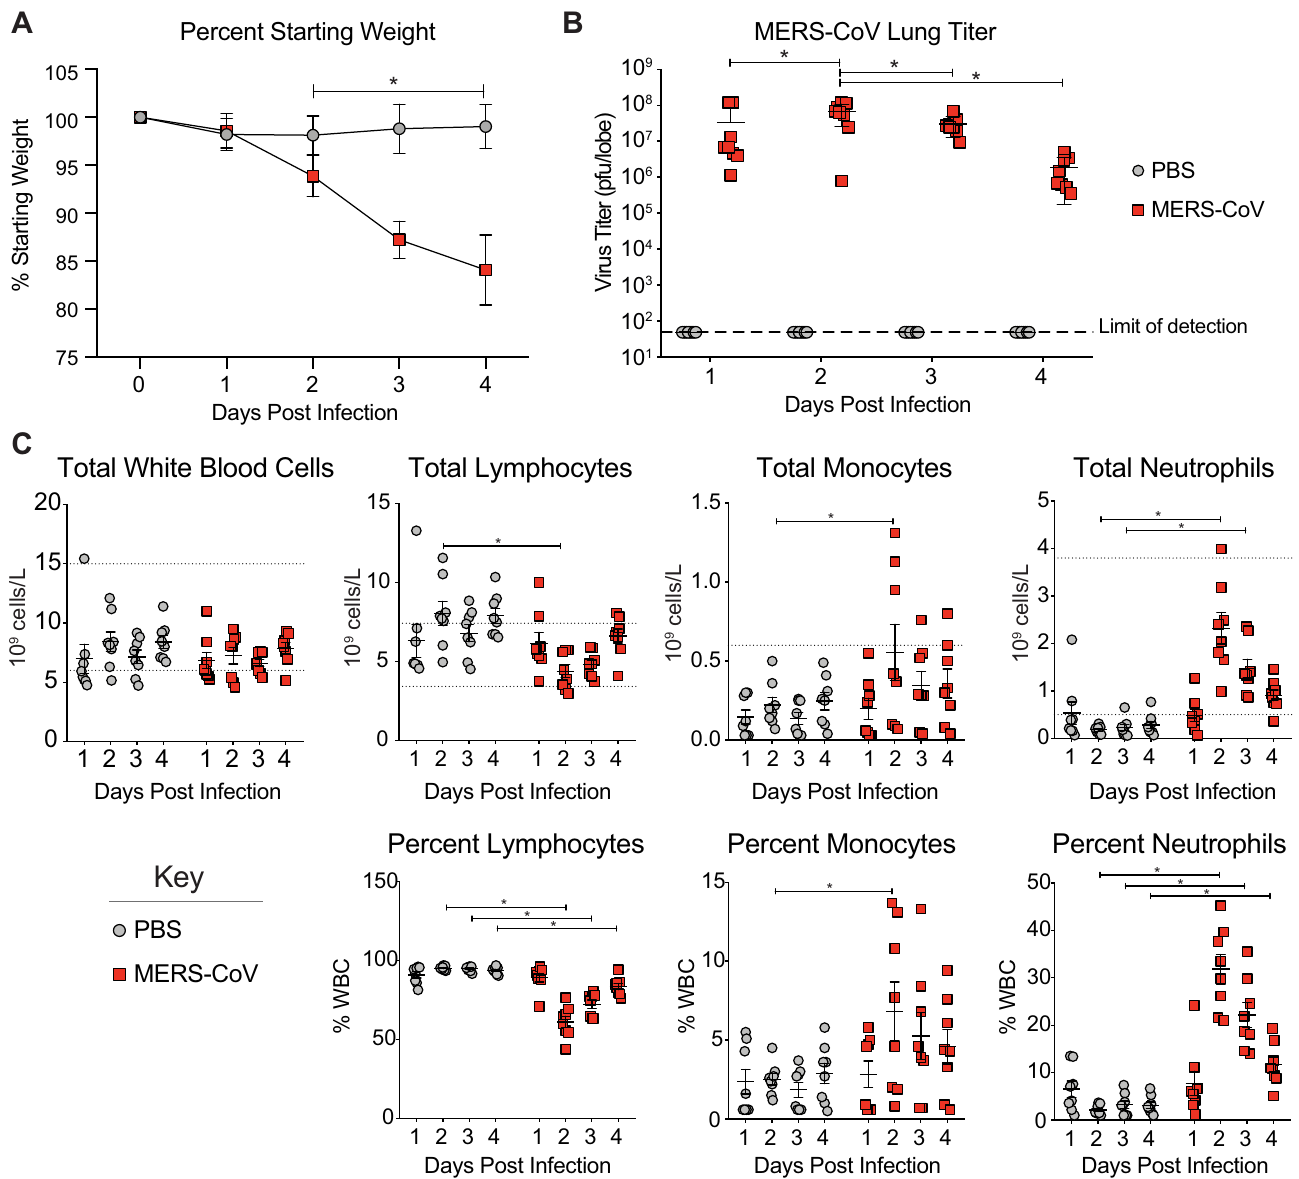
Fig 2. Peripheral leukocyte populations are modulated in MERS-CoV infection. (A) Percent starting weight of mock or MERS-CoV infected animals of mice described in Fig 1. The symbols represent the mean per time/group combined from two independent experiments and the error bars represent the standard deviation. Asterisks denote statistical significance as determined by two-way ANOVA with Sidek’s multiple comparison test. (B) Virus lung titer via plaque assay of mock or MERS-CoV infected animals combined from two independent experiments. Each symbol represents the titer for a single mouse. The line is at the mean titer and the error bars represent the standard deviation. Asterisks denote statistical significance as determined by two-way ANOVA with Tukey’s multiple comparison test. (C) VetScan hematology analysis. Data for total white blood cells (WBCs) as well as the numbers and frequencies of lymphocytes, monocytes and neutrophils are shown. All cell frequencies are expressed as a percentage of total WBCs. Each symbol represents the data from one mouse. The line is at the mean and the error bars represent the standard error of the mean. The dotted lines represent the normal expected range of each cell type according to the manufacturer. Asterisks denote statistical significance as determined by two-way ANOVA with Sidek’s multiple comparison test. [16]. Similar to the Vetscan measurement of “total white blood cells”, the frequency of CD45 + cells observed in both mock and MERS-CoV infected animals was consistent and invariant over time (Fig 3). Because a single common lymphocyte surface marker does not exist, we combined the independent frequencies of T cell, B cell, NK cell and NK T cell subsets to